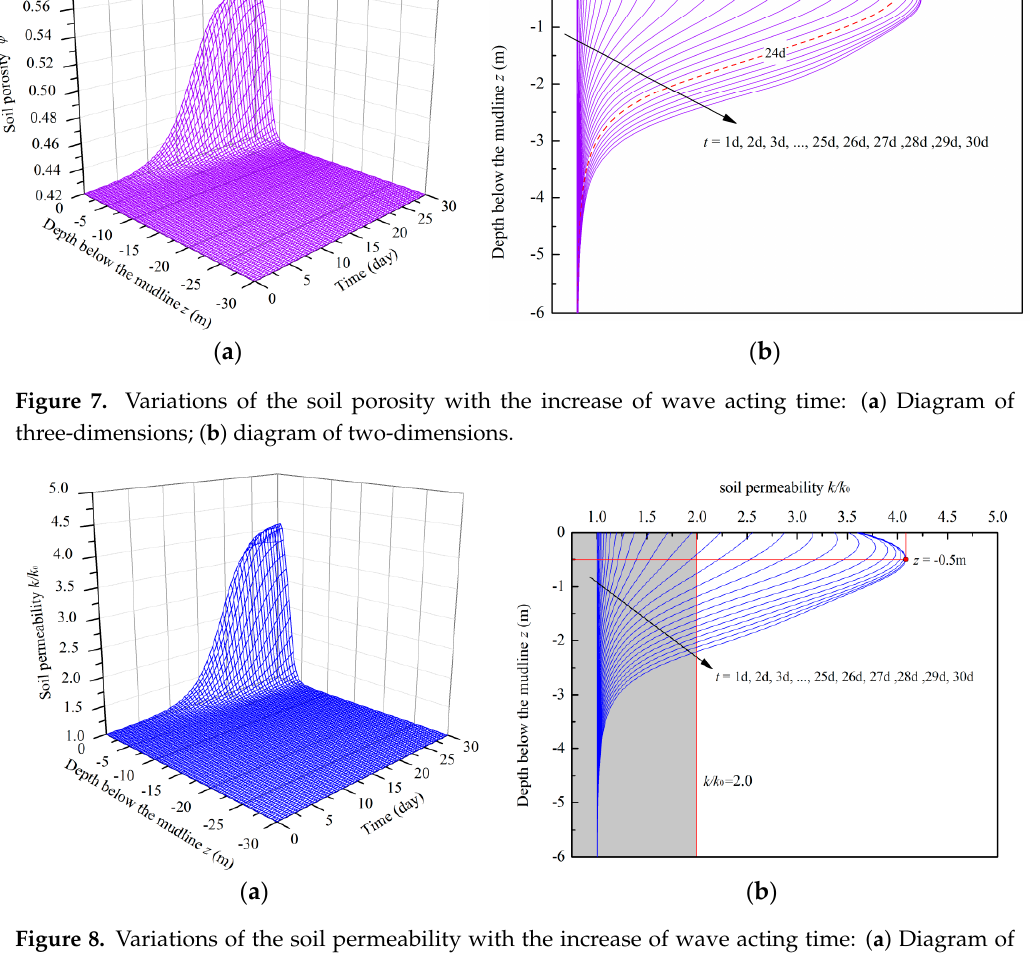
Figure 8. Variations of the soil permeability with the increase of wave acting time: ( a ) Diagram of three-dimensions; ( b ) diagram of two-dimensions.